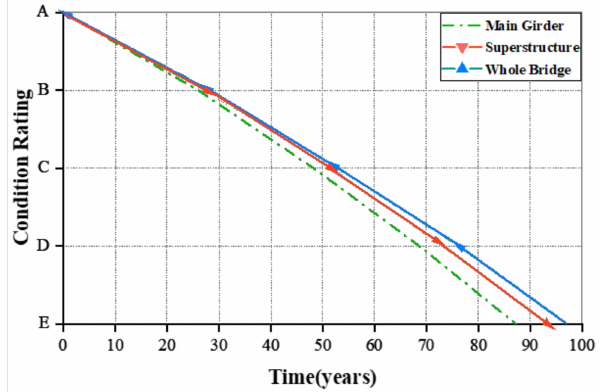
Figure 4. Life prediction for whole bridge, superstructure, and main